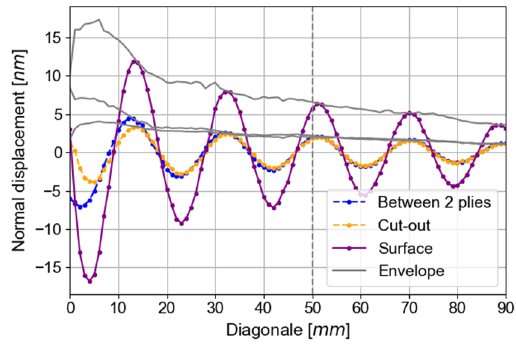
Figure 13. The amplitude of out-of-plane displacements for all tested generations at 50 kHz and 110 µs.